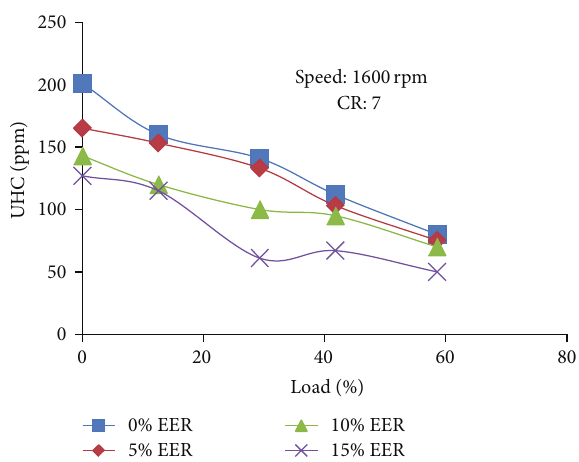
Figure 4: Effect of load on UHC concentration.